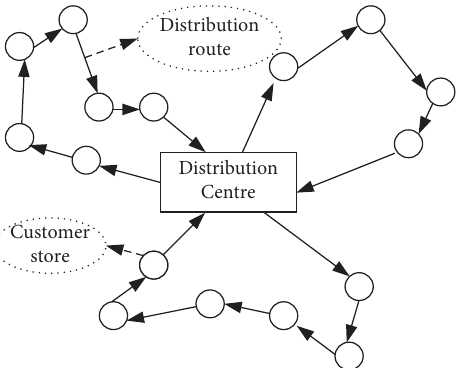
Figure 1: Schematic diagram of driving path of cold chain logistics distribution